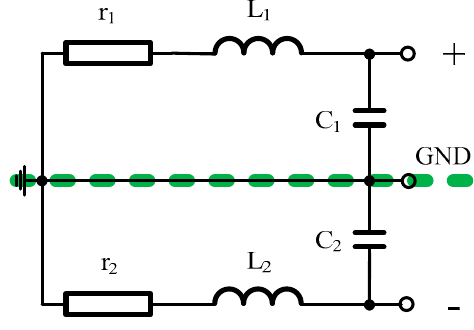
Figure 4. Electrical model of the air-core coil.